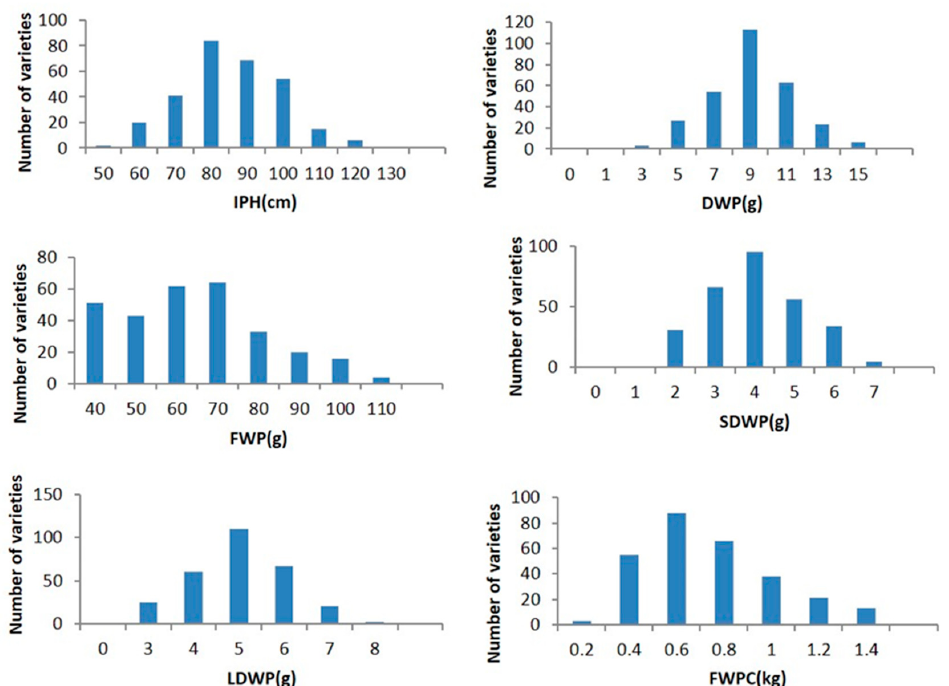
Figure 1. Frequency distribution of the 6 traits among the 301 ramie accessions (2019). Notes: IPH (individual plant height), FWP (fresh weight per plant), DWP (dry weight per plant), LDWP (leaf dry weight per plant), SDWP (stem dry weight per plant), and FWPC (fresh weight per clump).